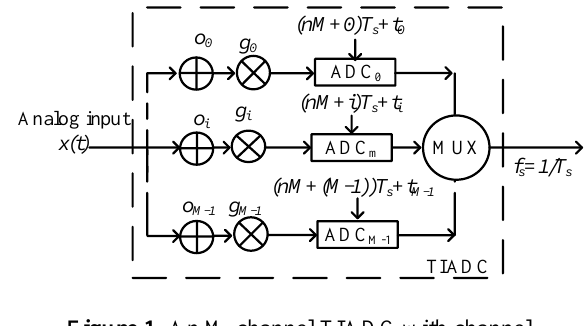
Figure 1. An M-channel TIADC with channel mismatches.